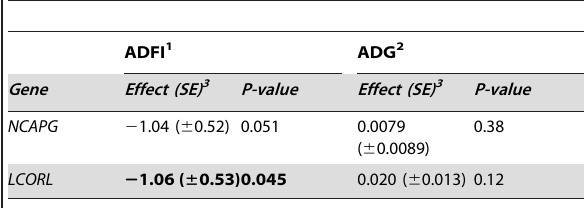
Table 2. Gene expression in heifer adipose tissue and association and estimated effects for ADFI and ADG.